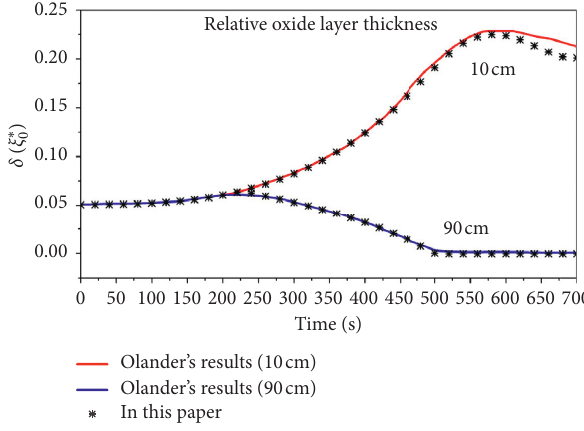
Figure 4: Comparison of fractional oxide layer thickness in cladding.